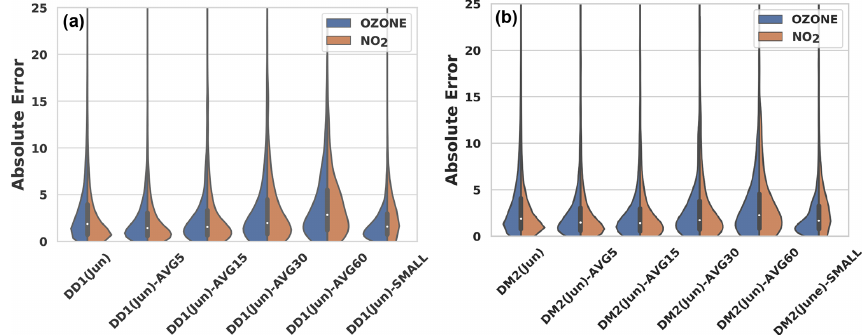
Figure 8. Effect of temporal data averaging and lack of data on the calibration performance of the KNN-D(ML) algorithm on temporally averaged and sub-sampled versions of the DD1(June) and DM2(June) datasets. Notice the visible deterioration in the performance of the al- gorithm when aggressive temporal averaging, e.g., across 30min windows, is performed. NO 2 calibration performance seems to be impacted more adversely than O 3 calibration by lack of enough training data or aggressive